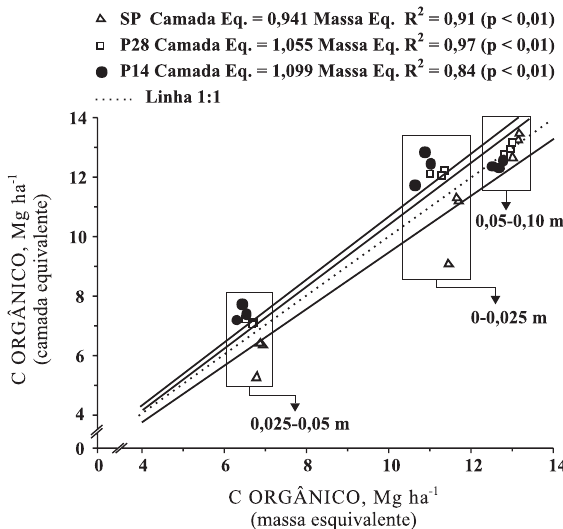
Figura 1. Comparação entre os estoques de C orgânico das camadas de 0–0,025, 0,025–0,050 e 0,050–0,10 m calculadas em massa e camada equivalentes de